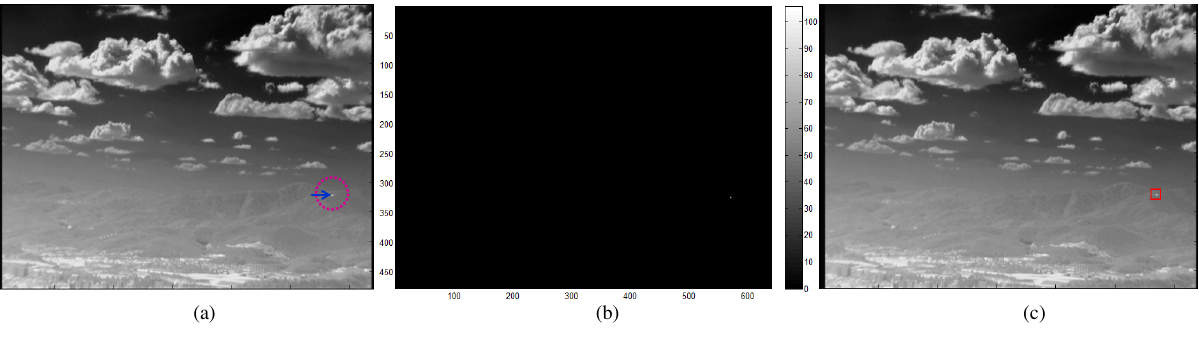
Figure 17. Example of the pixel velocity target candidate detector: ( a ) a passing-by target (elevation angle: 0 ◦ , yaw angle: 90 ◦ ); ( b ) the processing results of T CF of the proposed pixel velocity target